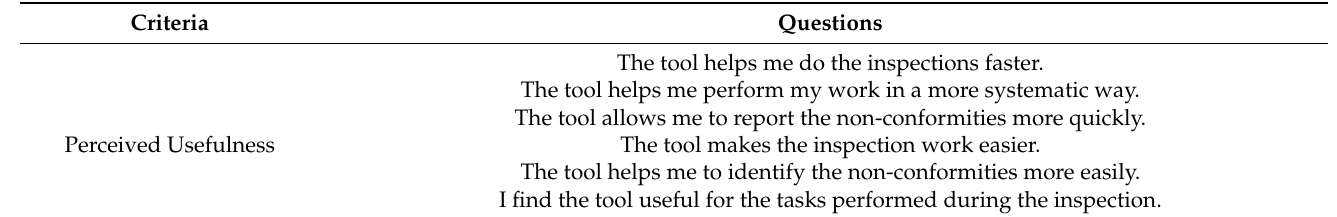
Table A2. List of the TAM and TIF questionnaire questions presented to the the factory’s quality control inspectors to measure the support tool’s usefulness and how well it meets their